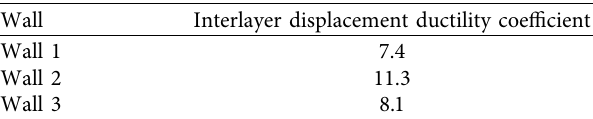
Figure 7: The relationship curve of the shear deformation angle of the core area. Table 1: Wall interlayer displacement ductility